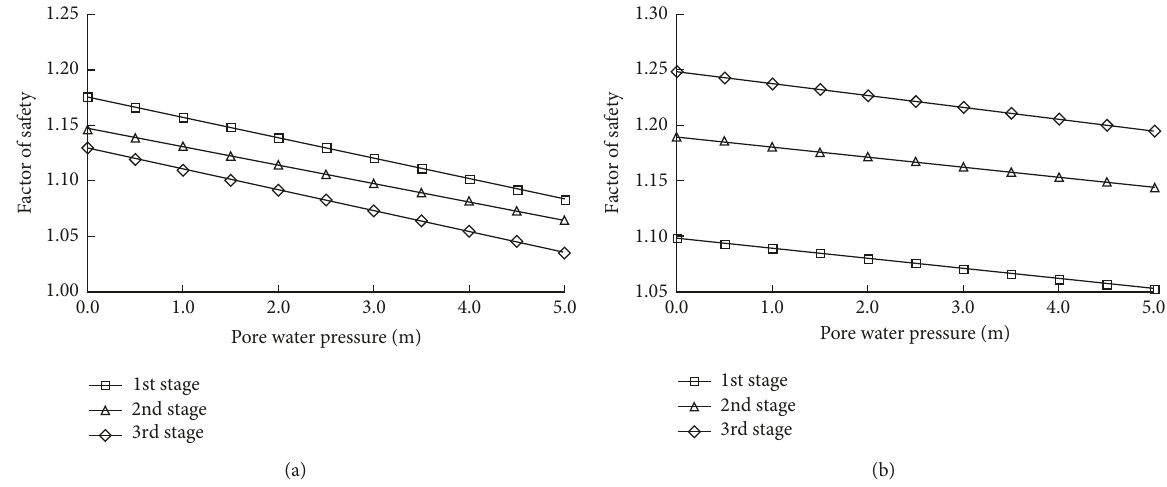
Figure 15: Safety factors for landslides under different pore water